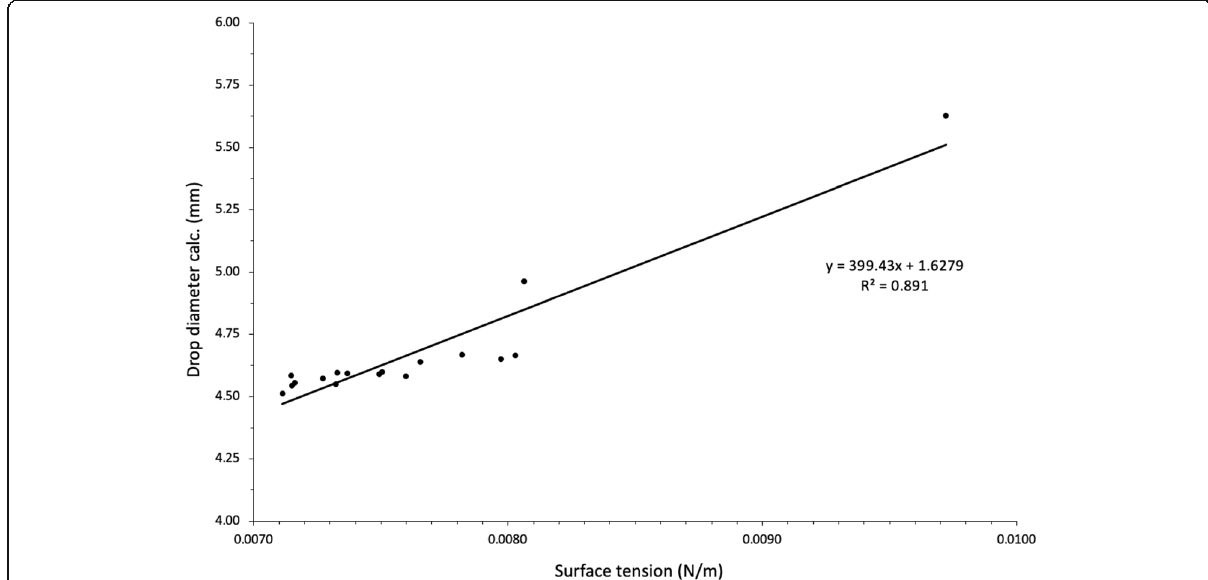
Fig. 2 The relationship between the surface tensions (N/m) of feed dispersions containing WPI:sucrose ratios of 1:0 and 1:1, bioactives contents of 0, 0.5, and 1%, and bioactives sources including pure gallotannin and Aronia berry, beet, and cranberry extracts at 25 °C, and calculated diameters (mm) of